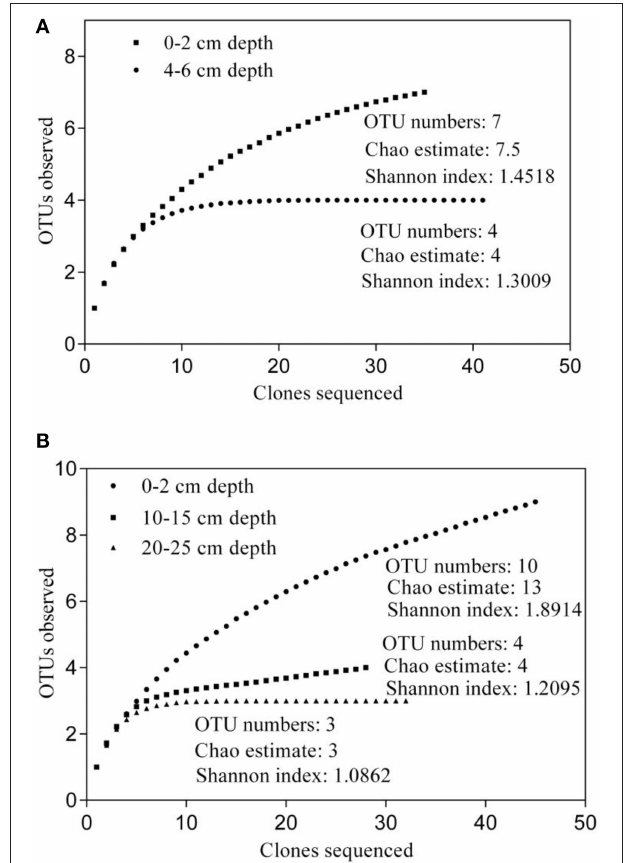
FIGURE 5 | Rarefaction analysis of ammonia-oxidizing bacterial (AOB) (A) and ammonia-oxidizing archaea (AOA) (B) communities in freshwater pond sediment. The DOTUR program was used with 3% sequence variation for AOB, or with 2% sequence variation for AOA, for the operation taxonomic unit (OTU)